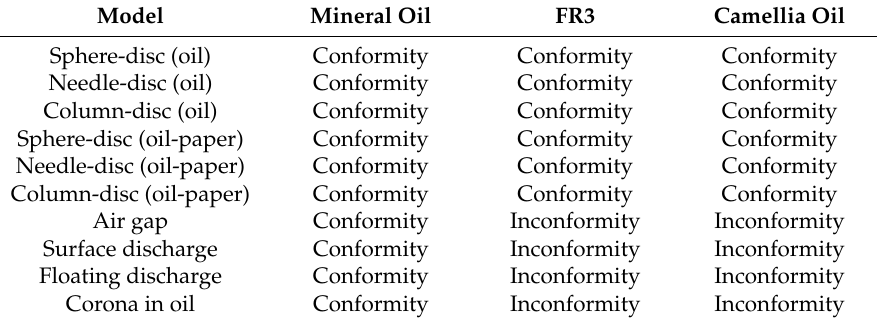
Table 9. Consistencies of diagnosis results and simulated fault types.